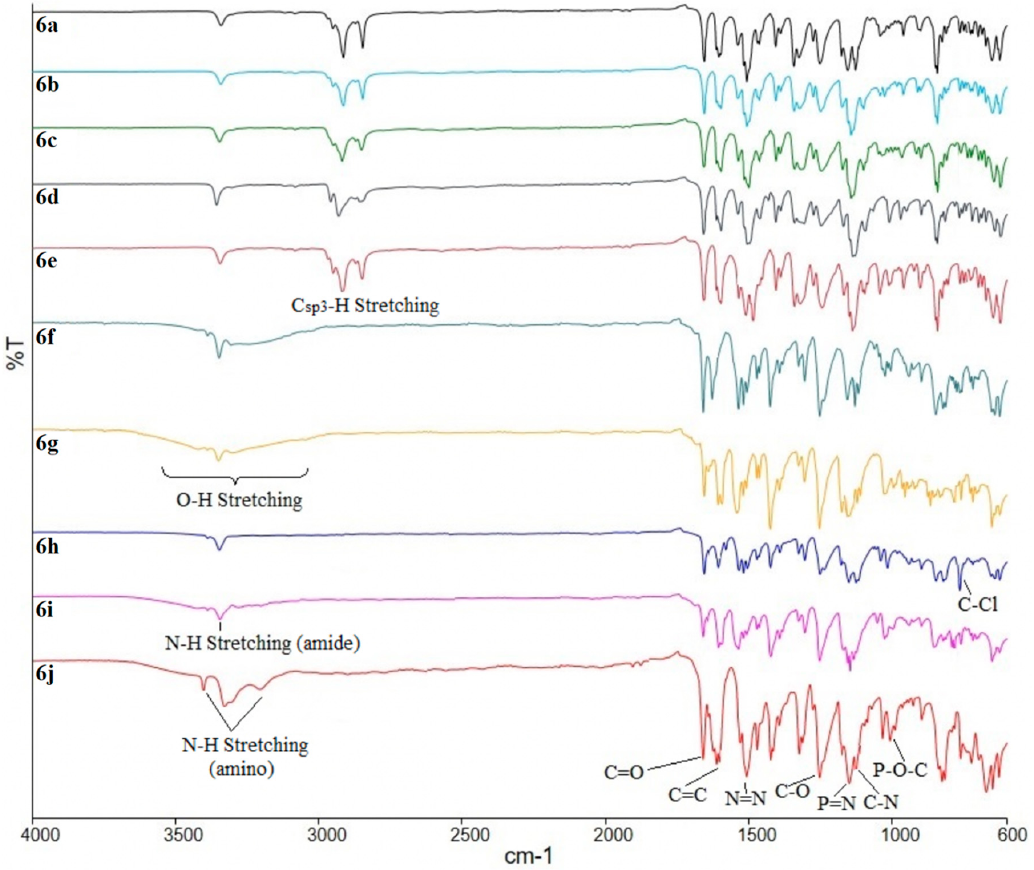
Figure 2. FTIR spectra overlay of compounds 6a–j (Series 1).